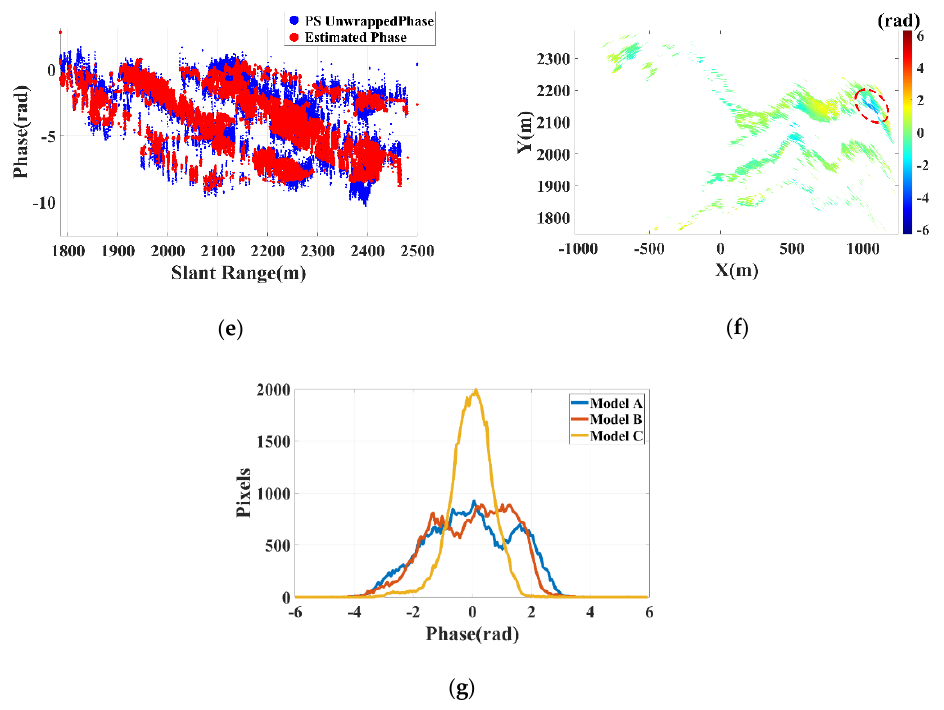
Figure 15. Phase scatter diagrams: ( a ) SD A ; ( c ) SD B ; ( e ) SD C . Compensation results: ( b ) CIM A ; ( d ) CIM B ; ( f ) CIM C . Comparison of different models: ( g ) Phase distribution curves of residual phases.